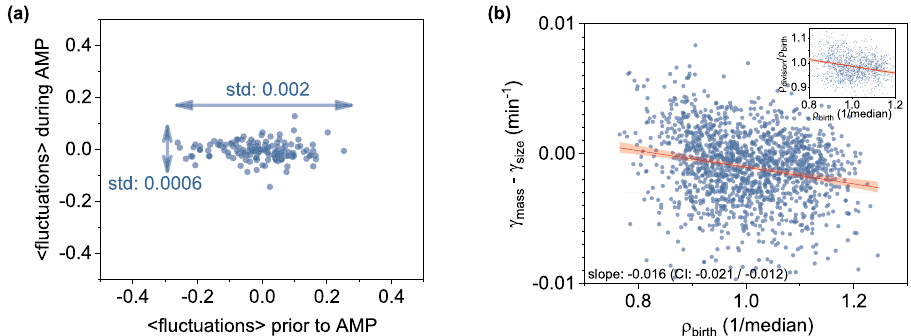
Fig. 3 Density homeostasis and density fl uctuations subsidence upon division inhibition. a Decrease of density fl uctuations under the ampicillin (AMP) pressure; legends denote the standard deviation of fl uctuations before ( horizontal arrow ) and during the ampicillin treatment (vertical arrow); graph represents the cumulative response of three replicates with each replicate presented separately in Supplementary Fig. 9. b Density homeostasis as evidenced by the monotonic decrease of γ mass − γ size with respect to the newborn cell density; inset displays the decreasing ratio of cell density prior to division ( ρ division ) over the cell density at birth ( ρ birth ) as a function of dry-density at birth ( ρ birth ). Both the main and inset graphs plot the combined three replicates, with each replicate presented separately in Supplementary Fig. 10 and Supplementary Fig. 11,